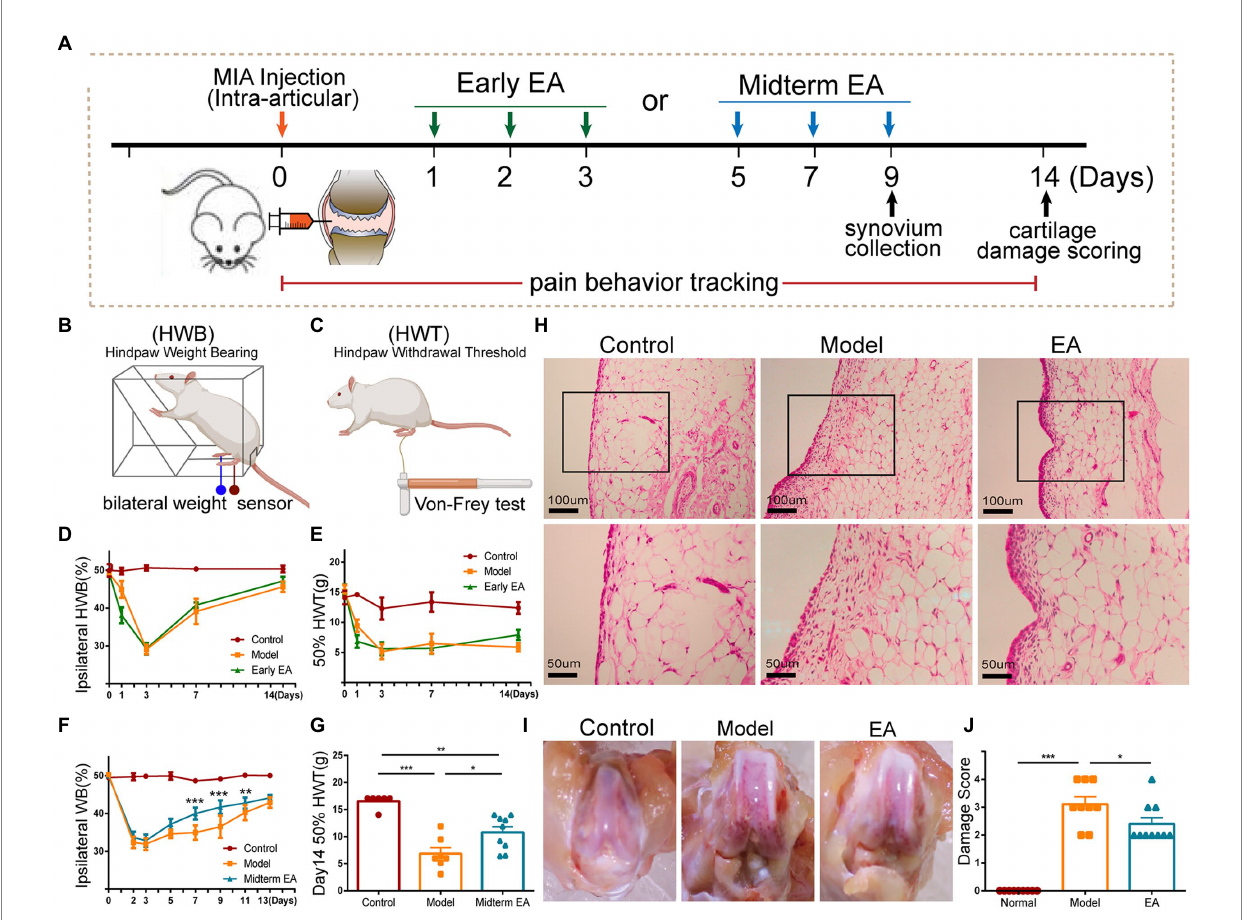
FIGURE 1 Midterm EA intervention alleviated the inflammatory pain behaviors in MIA-induced KOA rats. (A) The scheme on early EA and midterm EA. The percentage of ipsilateral weight bearing (WB) (B,D) and the 50% hind paw withdrawal threshold (HPWT; C,E ) in the model group and the early EA group was decreased from day 1 to day 14 after MIA injection in comparison with that of the control group, yet no significant difference was observed between the model group and the early EA group from day 3 to day 14 after MIA injection ( n = 6, p > 0.05). On day 1 after MIA injection, the percentage of ipsilateral WB and the 50% HPWT were even decreased in the early EA group in comparison with the model group. * p < 0.05, ** p < 0.01 vs. control. (F) The percentage of ipsilateral WB was increased in the midterm EA group on day 7 and day 9 after the MIA injection in comparison with the model group ( n = 10, * p < 0.05, ** p < 0.01, *** p < 0.001). (G) The ipsilateral 50% HPWT in the midterm EA group was increased on day 14 after the MIA injection in comparison with that of the model group ( n = 10, * p < 0.05, ** p < 0.01, *** p < 0.001). (H) On day 9 after MIA injection, hyperplasia and inflammatory cell infiltration of the synovium occurred in the model group, which was alleviated in the midterm EA group. (I) On day 14 after the MIA injection, cartilage damage occurred in the model group, which was alleviated in the midterm EA group ( n = 3). (J) The cartilage damage score in the midterm EA group was decreased in comparison with that in the model group on day 14 after the MIA injection ( n = 9, * p < 0.05, ** p < 0.01, *** p <